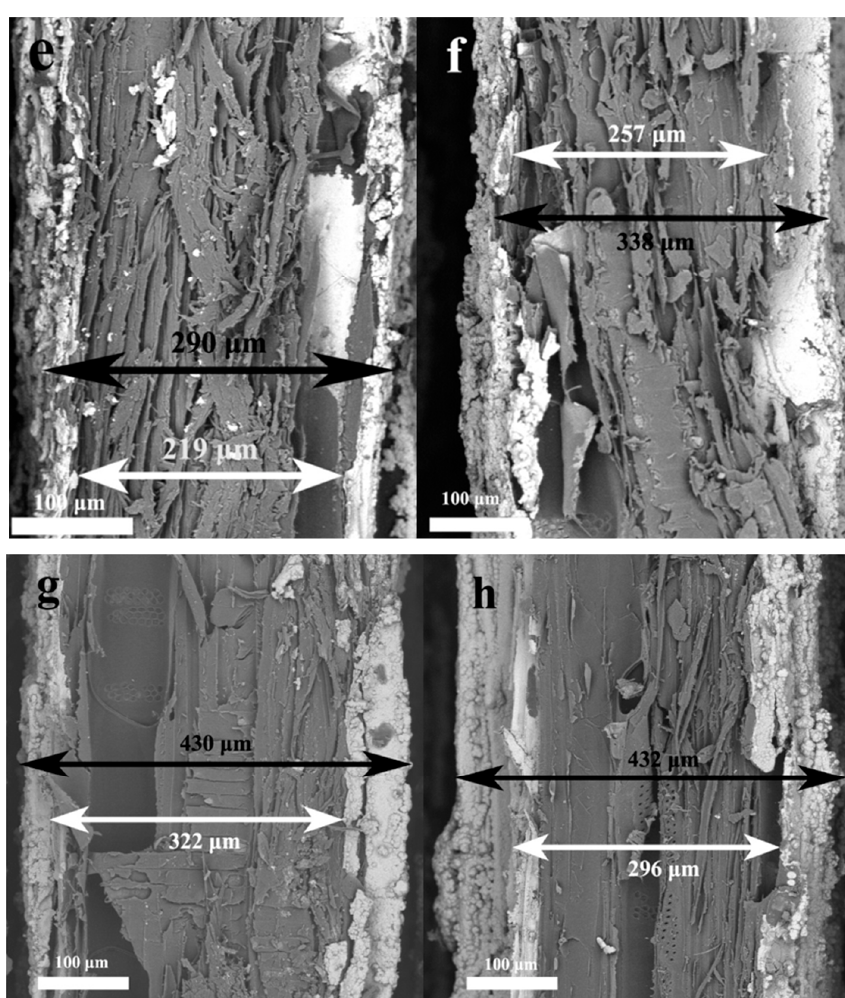
Figure 4. ( a – f ) is the interface diagram of the materials at different times during one electroless Ni (( a ): 1 min, ( b ): 5 min, ( c ): 10 min, ( d ): 15 min, ( e ): 20 min, ( f ): 25 min, ( g ): interface diagram of two electroless Ni for 20 min, ( h ): interface diagram of third electroless Ni for 5 min. Table 2. Section thickness of wood-based composites.